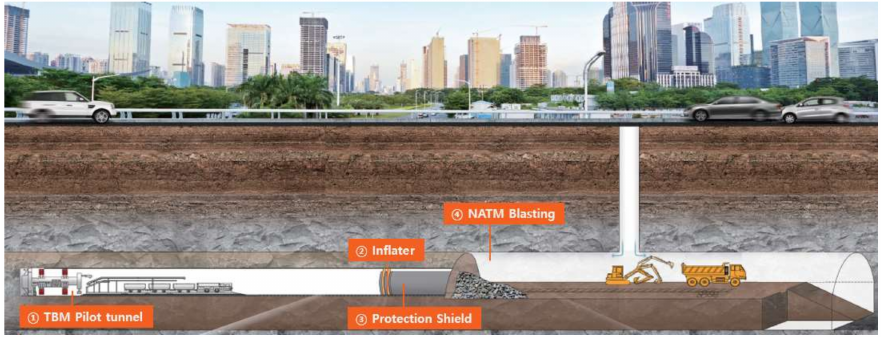
Figure 1. Simultaneous excavation using tunnel boring machines (TBM) and New Austrian tunneling method (NATM) enlargement with protection